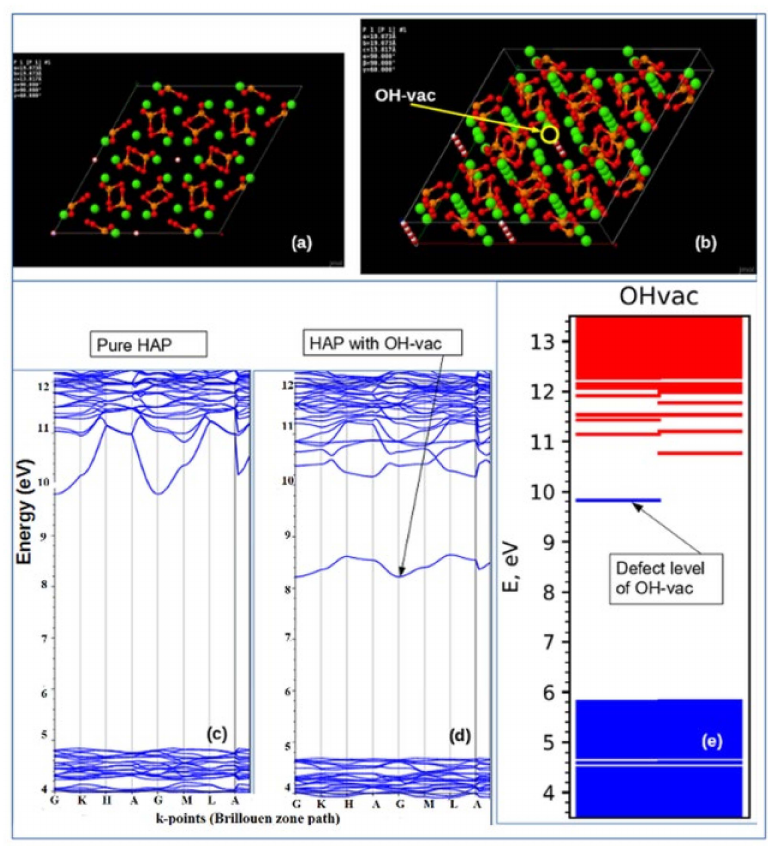
Figure 13. Model of OH-vacancy in HAP supercell: ( a ) top view on HAP supercell; ( b ) OH-vacancy in HAP supercell (iso projection); ( c ) band structure of pure HAP; ( d ) band structure of HAP with OH-vacancy computed using VASP; ( e ) band structure of HAP with defect level from OH-vacancy computed using Quantum